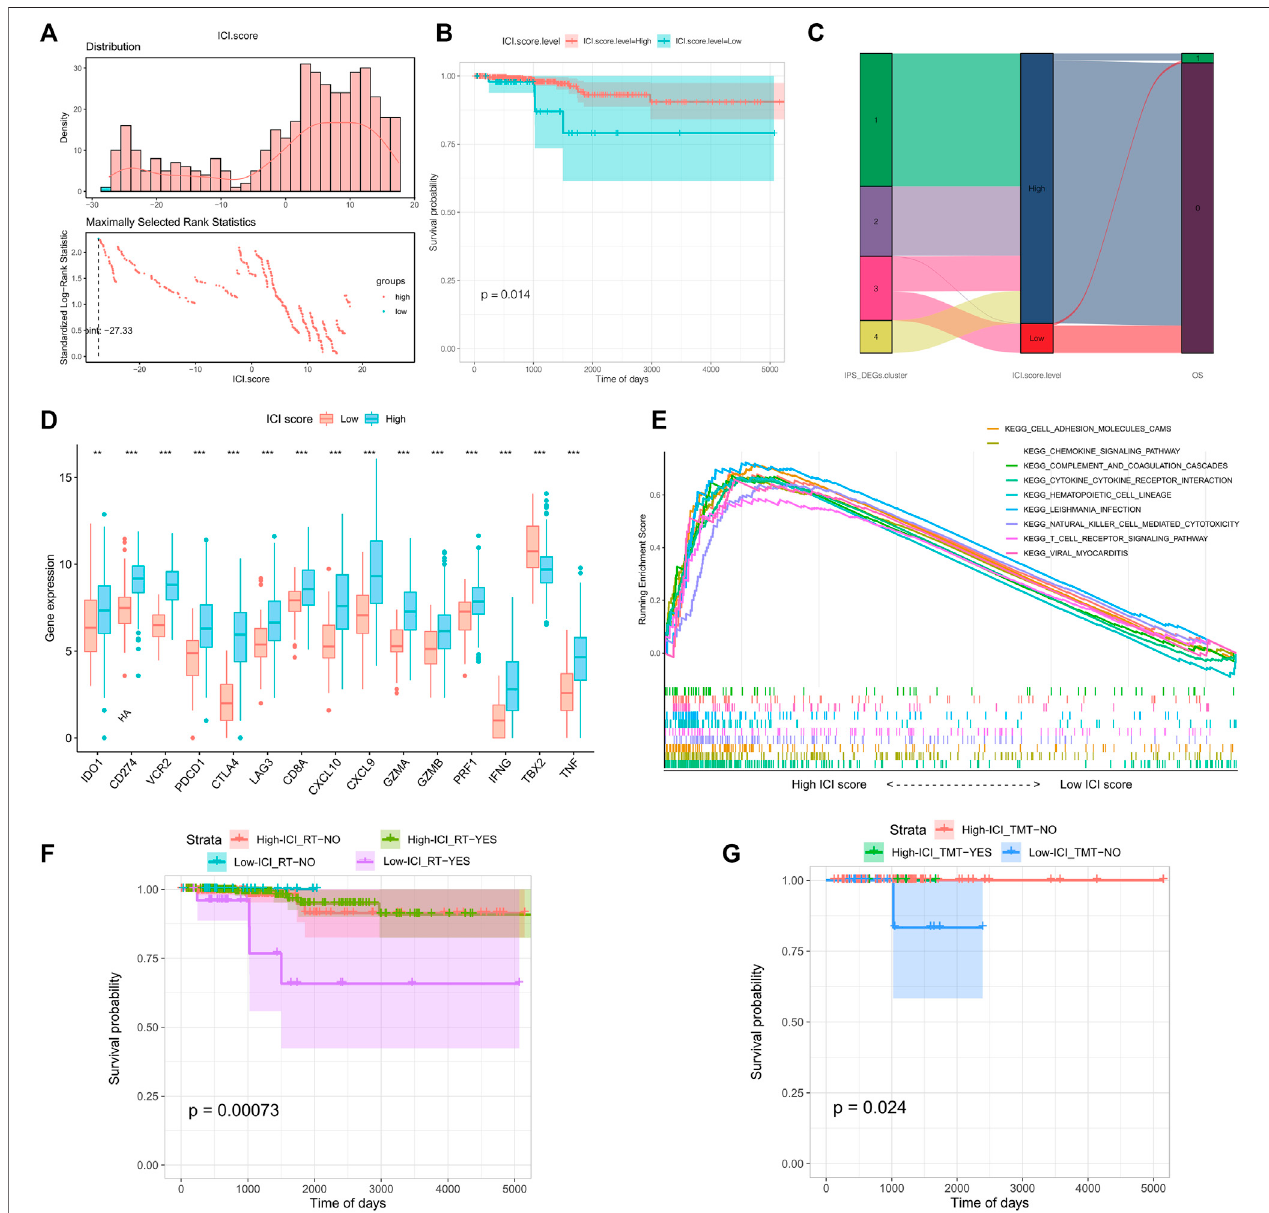
FIGURE 3 | Grouping and model construction of tumor immune cell in fi ltration scores (ICI scores). (A) Distribution (above) and the selection of the best density gradient points (below) of immune cell in fi ltration score (ICI scores); (B) survival curve between high and low ICI scores; (C) Sankey diagram of immune gene subtypes, ICI scores grouping and survival status; (D) Differences in immune checkpoints and immune activation gene expression between ICI scores groups; (E) Gene set functionenrichmentofdifferentiallyexpressedgenesbetweenICIscoresgroups; (F) SurvivalcurvebetweenradiotherapyandICIscoresgroups; (G) Survivalcurve received therapy in different ICI